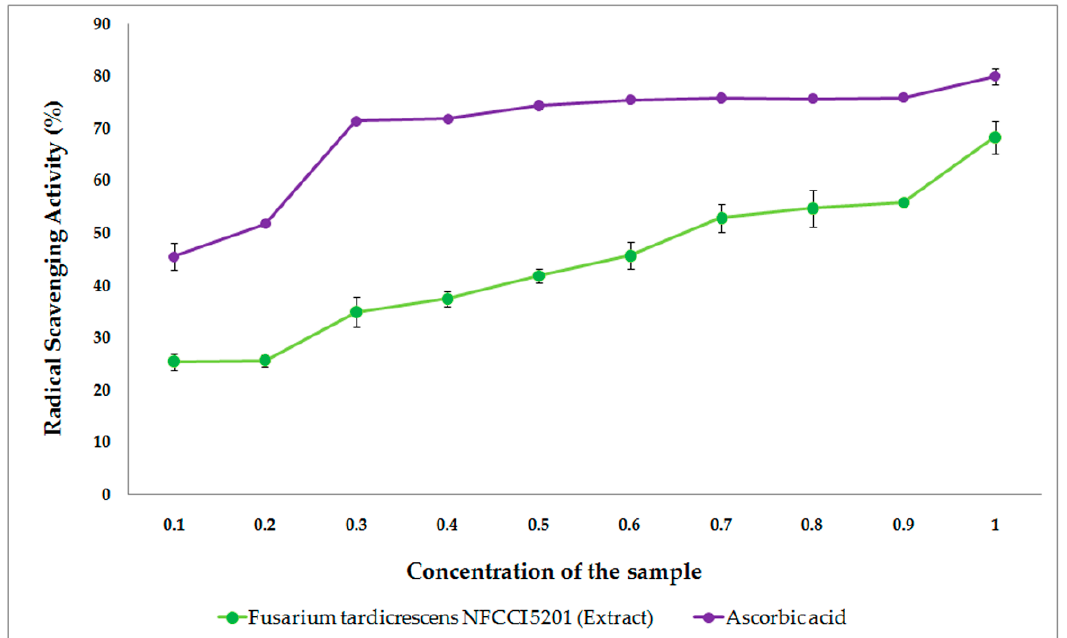
Figure 11. The free radical scavenging activity of the extract of F . tardicrescens NFCCI 5201 containing beauvericin (mg/mL) and the standard ascorbic acid (mg/mL) when tested for in vitro antioxidant activity.